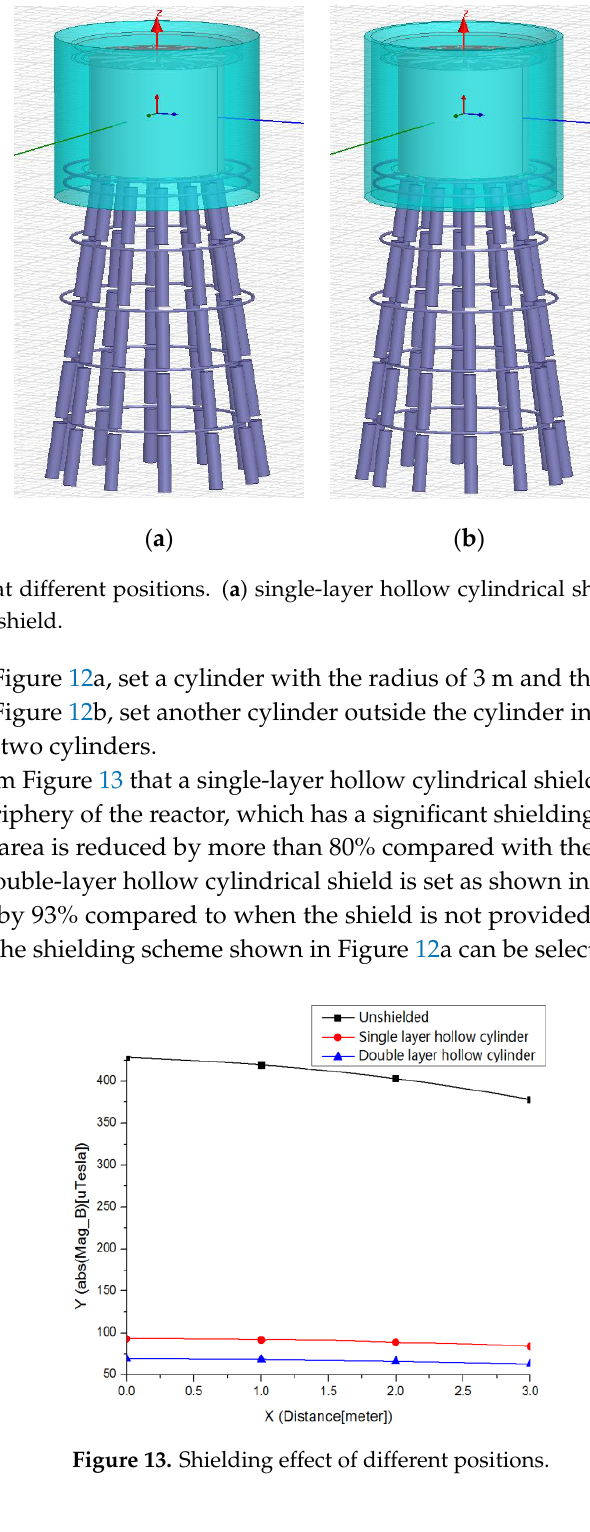
Figure 13. Shielding effect of different positions.